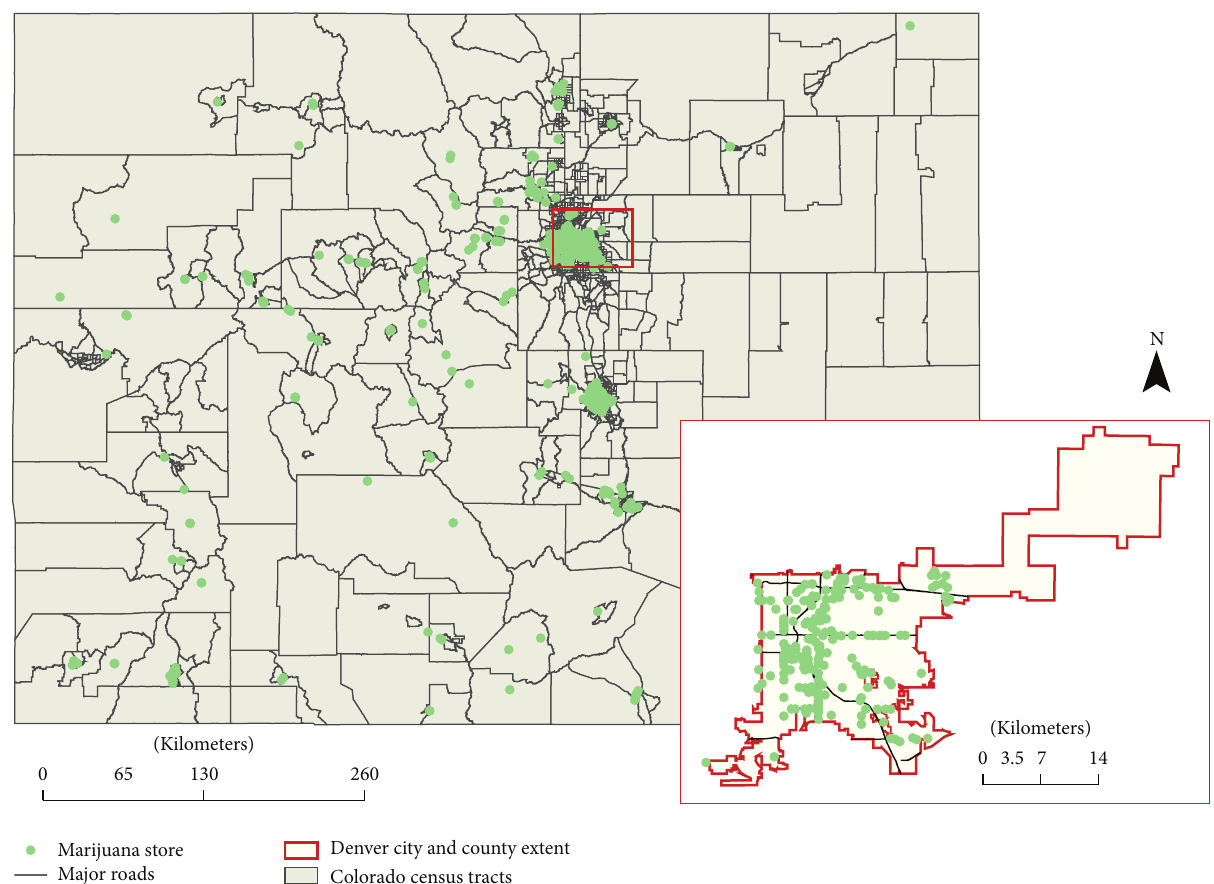
Figure 1: Spatial distribution of marijuana stores at census tract level in Colorado (census tract 𝑁 = 1